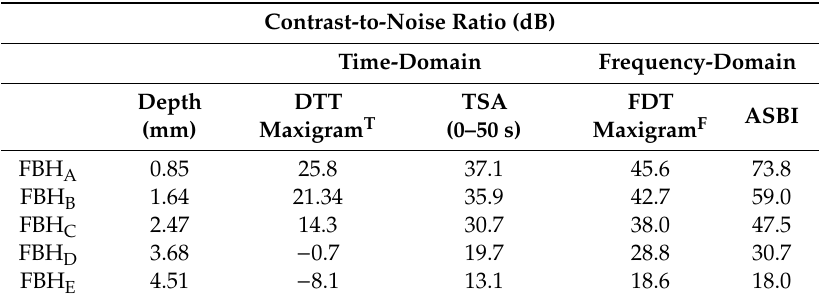
Table 1. Contrast-to-noise ratio (CNR) for all FBHs of the CFRP FBH coupon sample. Contrast-to-Noise Ratio (dB) Time-Domain